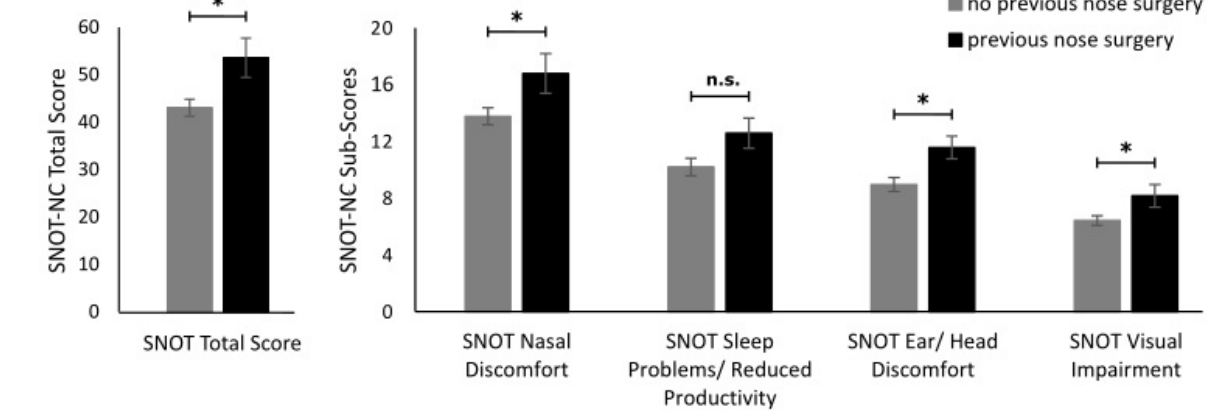
Figure 1. Illustration of the SNOT-NC Total Score (left side) and SNOT-NC Sub-Scores (right side) comparison for patients with (black) and without previous nasal surgeries (grey). Asterisks * mark significant differences.